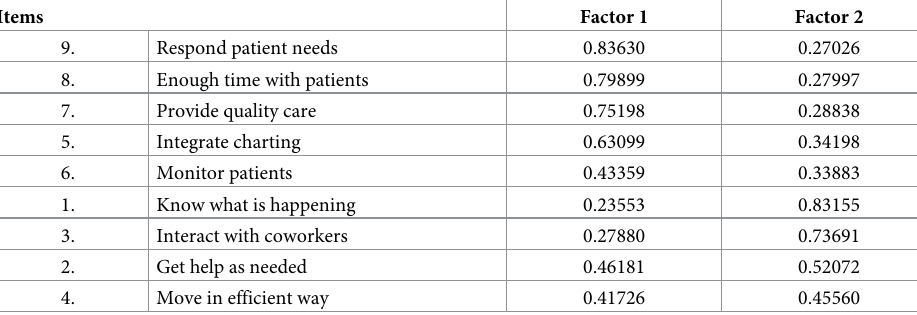
Table 12. Phase 4 varimax rotated two-factor model